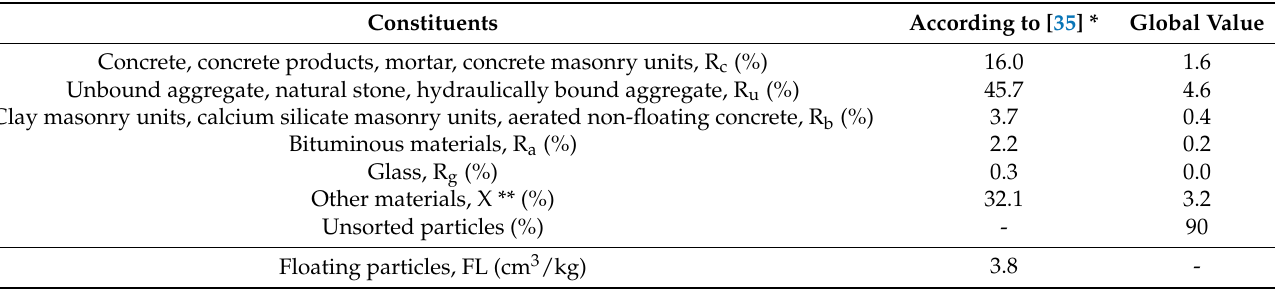
Figure 2. Particle size distribution curve of the recycled C&D material. Table 1. Constituents of the recycled C&D material.